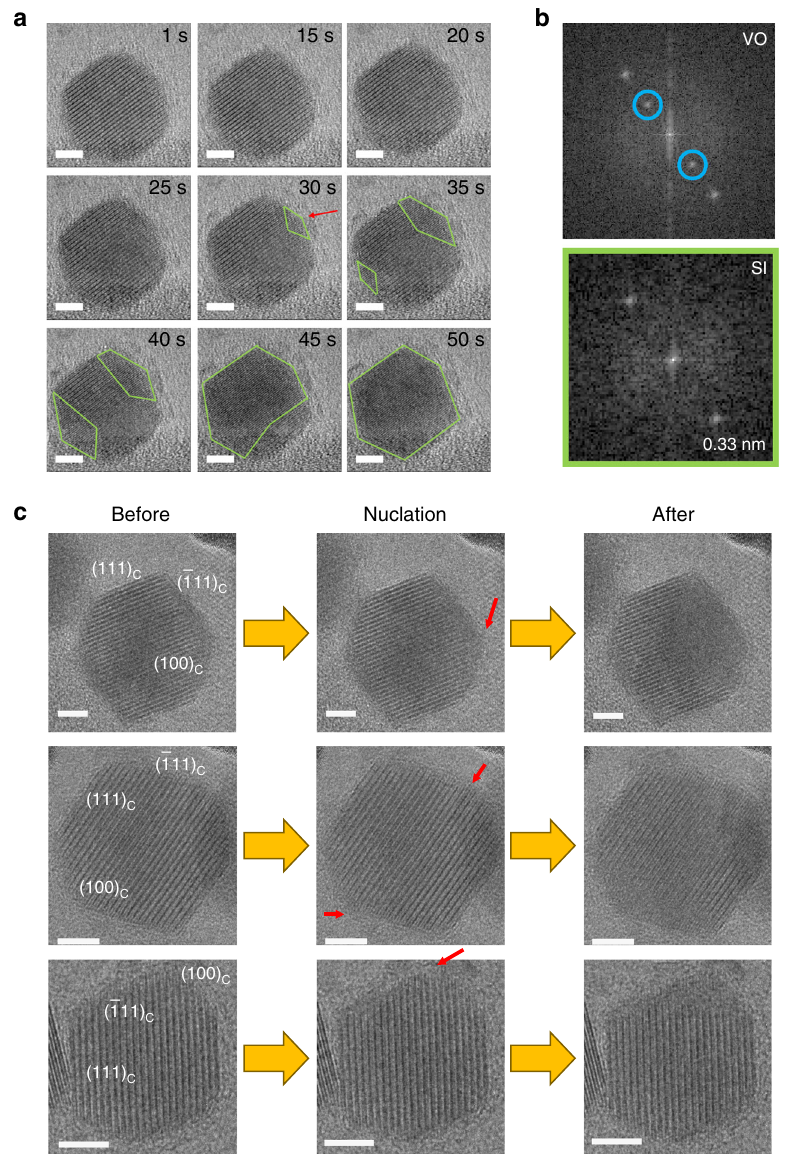
Fig. 1 HRTEM imaging of the order – disorder phase transition in Cu 2 − x Se HNPs. a Selected movie frames from continuous HRTEM imaging of an HNP undergoing a transition from the vacancy-ordered (VO) phase to the superionic (SI) phase. The time relative to the start of the movie is indicated for each frame. Before t = 30 s, there is nucleation of a cation-disordered region at the location labeled by the red arrow. The SI phase (marked by green outlines) grows across the HNP over time. b FFT of the VO region (top) and SI region (bottom) of the HNP, obtained from the t = 35 s frame shown in Fig. 1a. The VO phase shows characteristic vacancy super-lattice spots ( d ~ 0.68 nm, marked by blue circles) in the FFT, which are absent for the SI phase. c HRTEM snapshots of an HNP before, around, and after the point of nucleation of the order – disorder transition. Corresponding FFTs are shown in Supplementary Fig. 3. This evolution is shown for three different HNPs (one per row). The nucleation site, where vacancy-ordering is fi rst observed to be lost, is marked by a red arrow in each case. This site was identi fi ed on the basis of a difference in the local lattice fringe pattern in the before and after frames. It is found that nucleation occurs at a vertex site at the intersection of ( (cid:1) 111) c and (100) c surface facets. These surface facets (labeled in the leftmost image of each row) were assigned on the basis of FFT analysis of the HRTEM images of individual HNPs, as described in Supplementary Fig. 4. Scale bars in images are 5 nm in